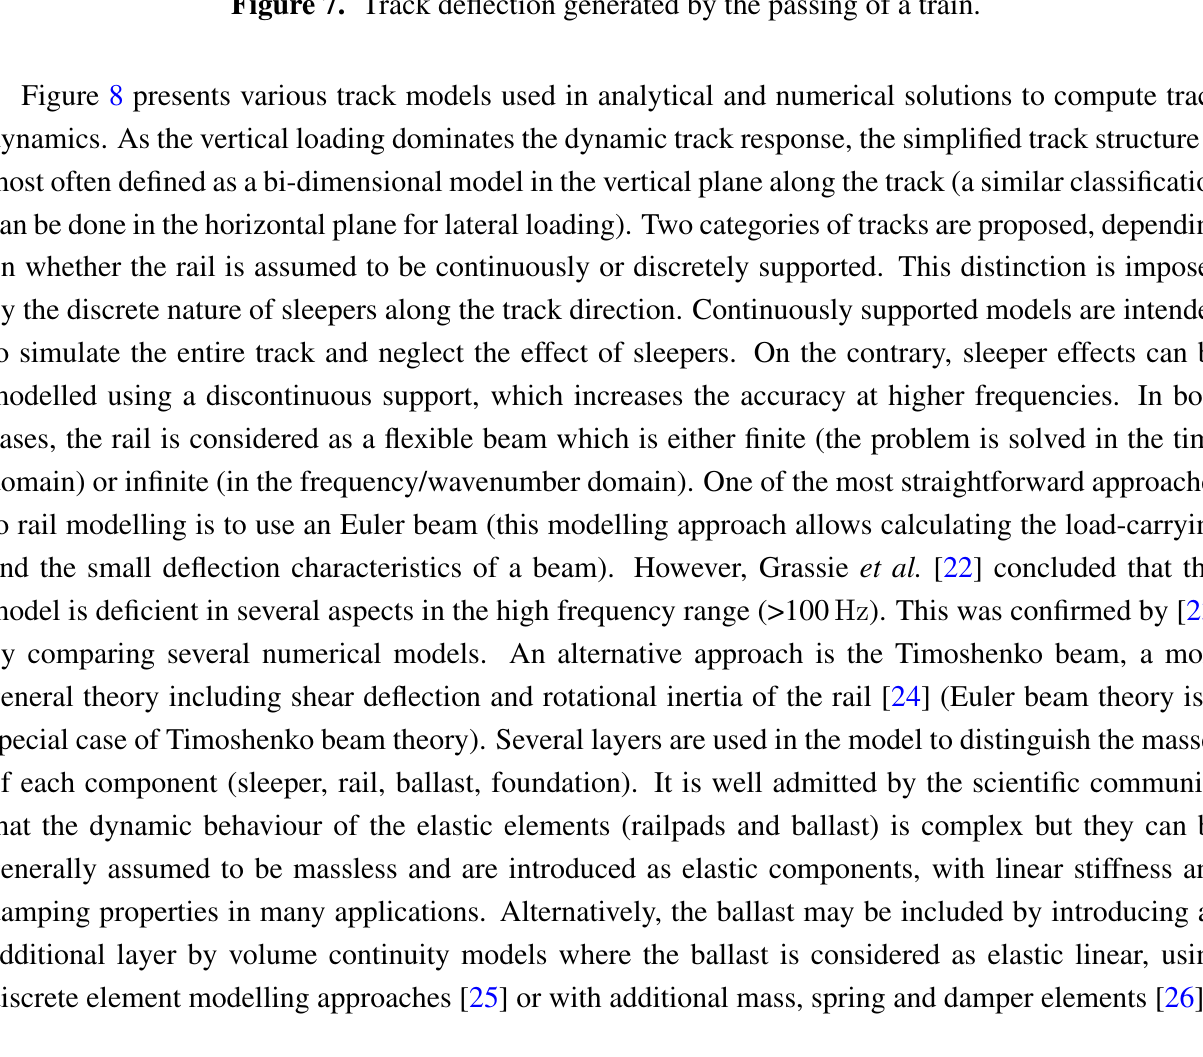
Figure 7. Track deflection generated by the passing of a